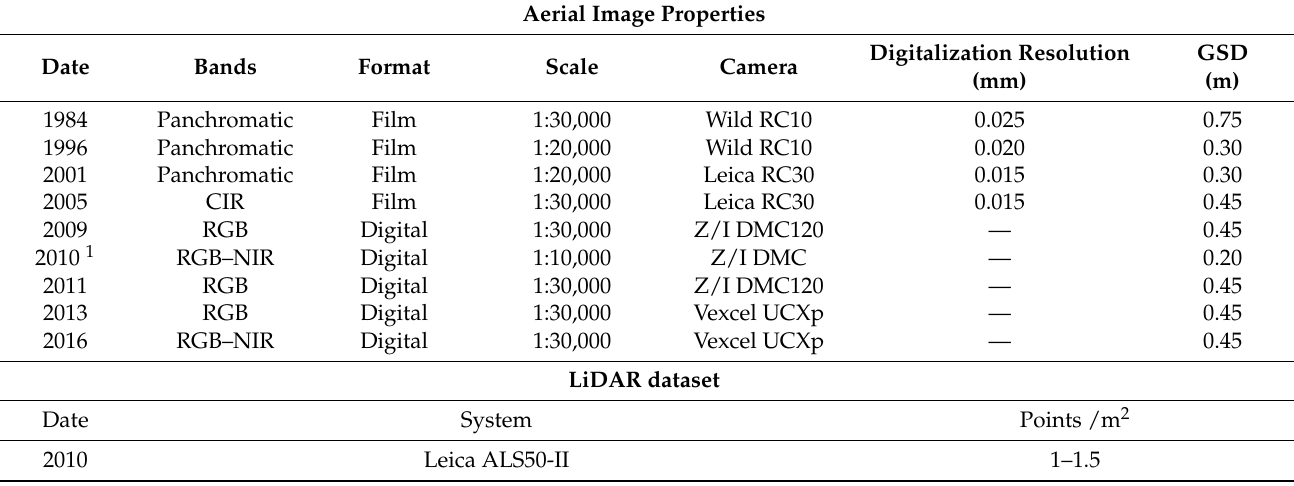
Table 1. Properties of the aerial images and LiDAR data